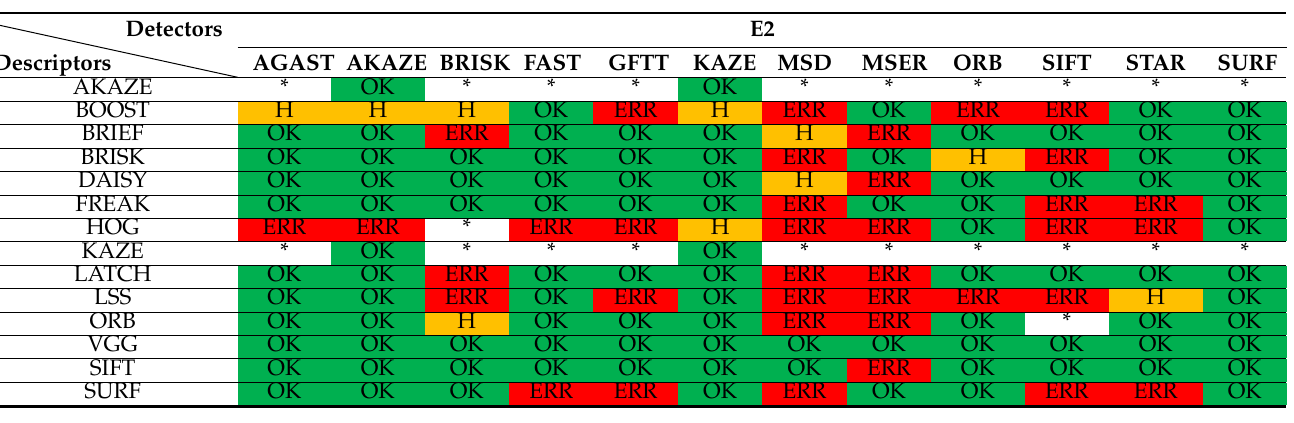
Table A2. The results of matching performed for elevation 2. The description is performed according to Equation (10), and the “*” symbol means descriptor not available.